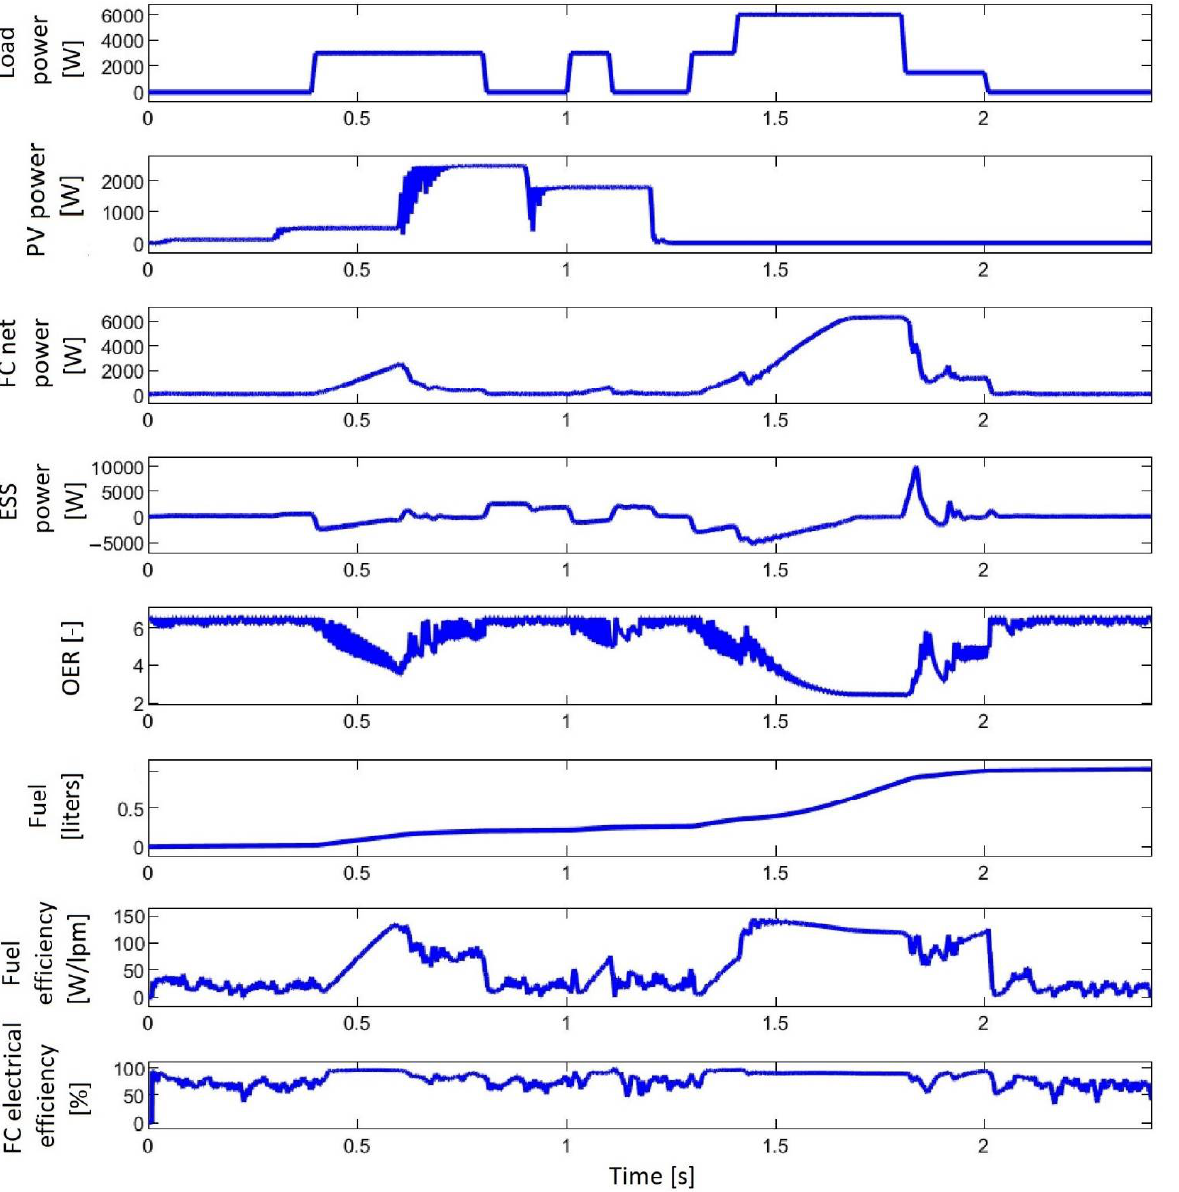
Figure 12. The behavior of the PV/FC/ESS system using strategy S2 in the scenario SC4. As the load demand profile is increased compared to scenario SC3, more FC power will be requested to compensate the power flow balance on the DC bus. Thus, the total